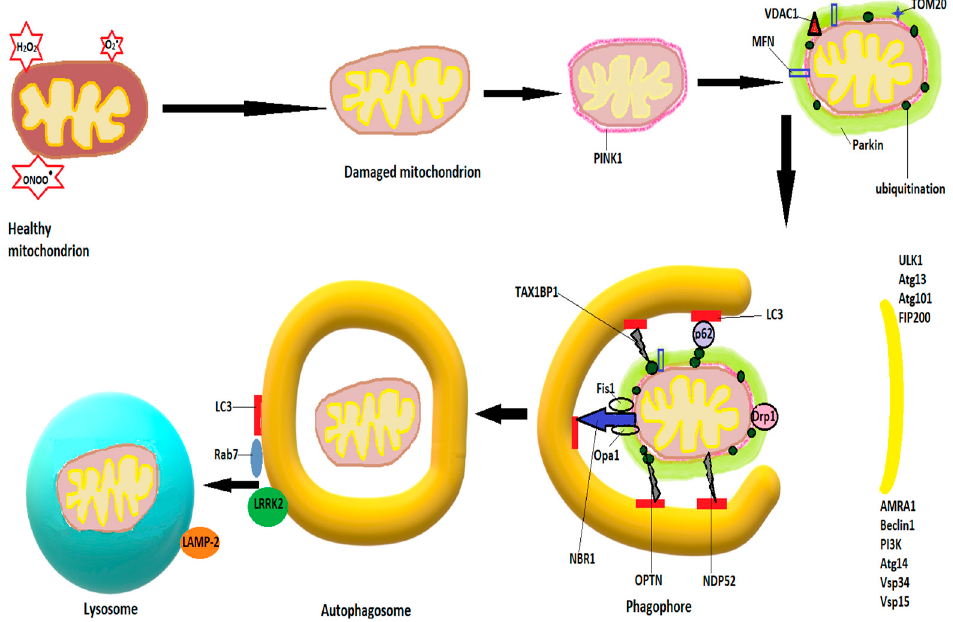
Figure 2. Schematic diagram of mitophagy. The mitophagy induction process activates PINK1, which accumulates on the OMM and recruits and phosphorylates Parkin. The latter ubiquitinates OMM proteins, such as mitofusins 1 and 2 (Mfn), voltage-dependent anion channels 1 (VDAC1), and TOM20 (translocase of the outer mitochondrial membrane 20). Autophagosome formation starts with activation of the pre-initiation complex, containing ULK1 (Unc-51-like kinase 1), Atg 13 and 101 (autophagy-related proteins), and FIP200 (focal adhesion kinase family interacting partner 200), and continues with recruitment of class III phosphatidylinositide 3-kinase (PI3K), beclin1, Atg 14, AMBA1 (autophagy and beclin 1 regulator), and Vps 34 and 15 (vascular protein sorting), resulting in the production of phosphatidylinositol 3-phosphate (PI3P). The ubiquitinated proteins recruit autophagy adaptor proteins, such as neighbor BRCA1 gene (NBR1), optineurin (OPTN), Tax-1 binding protein (TAX1BP1), nuclear dot protein 52 (NDP52), or sequestosome-1, which interact with